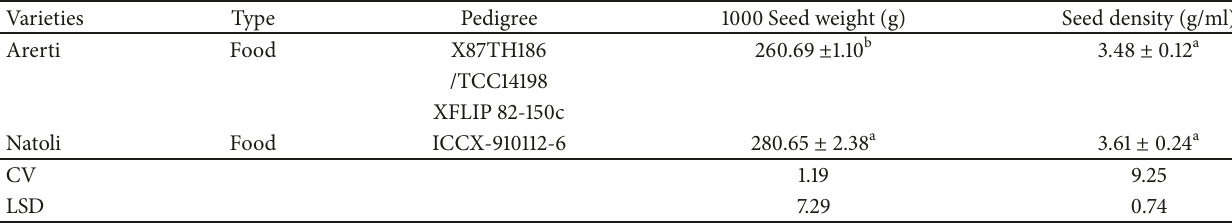
Table 1: General characteristics of the seeds of the two chickpea